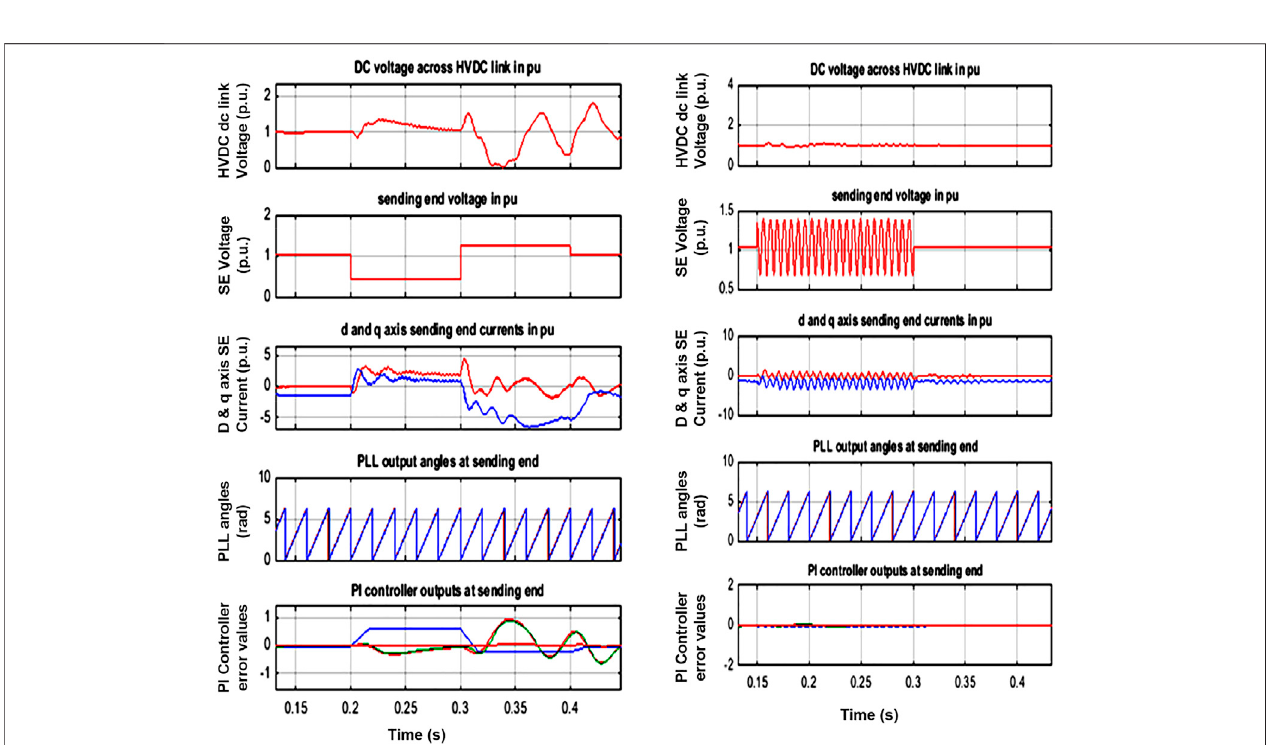
FIGURE 12 | HVDC dc-link common voltage and SE voltage, d and q axis currents at SE, PLL angles at SE, and current PI controller error values with (i) control scheme (Moawwad et al., 2016) and (ii) proposed technique.